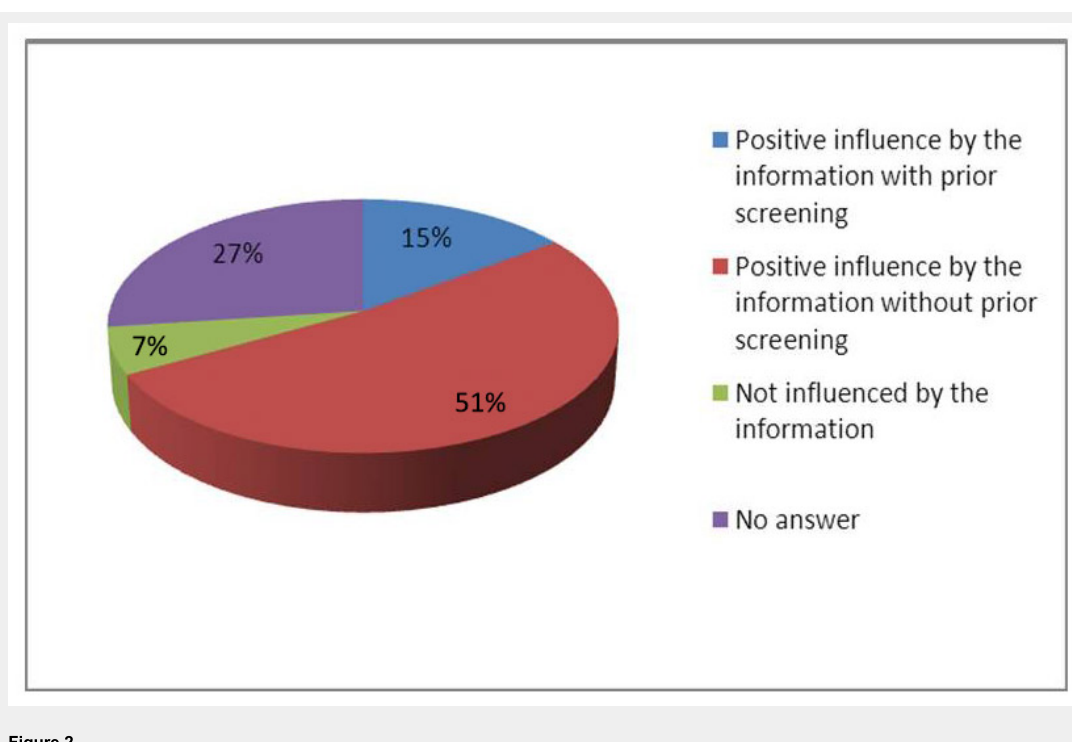
Figure 2 Impact of the “on-site prevention and education” concept regarding the incentive towards a regular cardiac